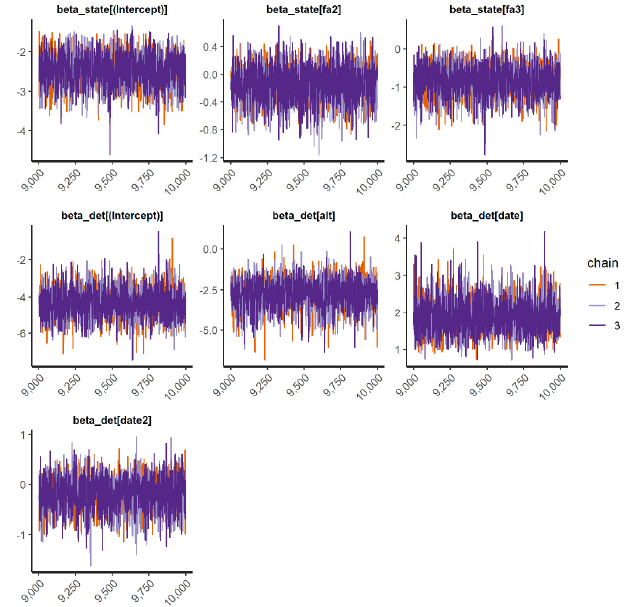
Figure A13. Traceplots from the second-best occupancy model (the top-ranked model did not converge well) of Cuban tree frog ( Osteopilus septentrionalis ) in Puerto Rico: ( ψ (intercept + fa2 + fa3); 𝜌 (intercept + elevation + date + date2)). Note: alt = elevation; fa2 = proportion of forest cover aged between 32 and 54 years; fa3 = proportion of forest cover aged 55 years and older; date = Julian date (we considered Julian day 1 as the first day of a device starting to record in the field, which was 1 March 2021); date2 = square of Julian date.